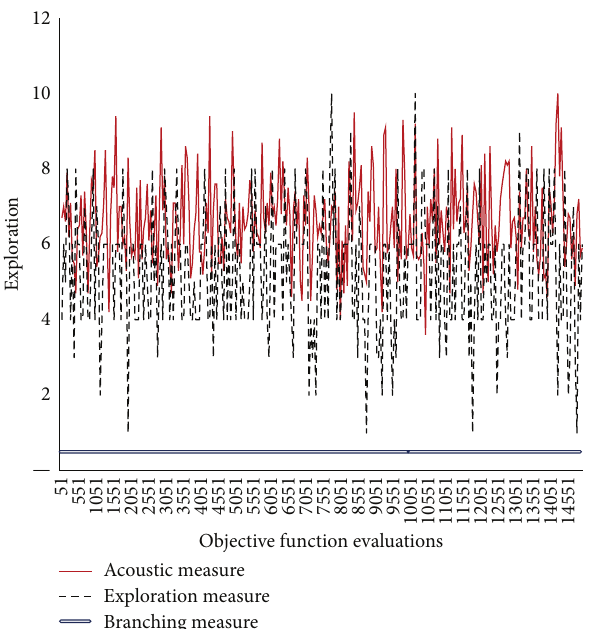
Figure 8: Evaluating ACO ustic against traditional indicators in ACO for the QAP instance kra30a with nearest neighborhood threshold = 𝜖